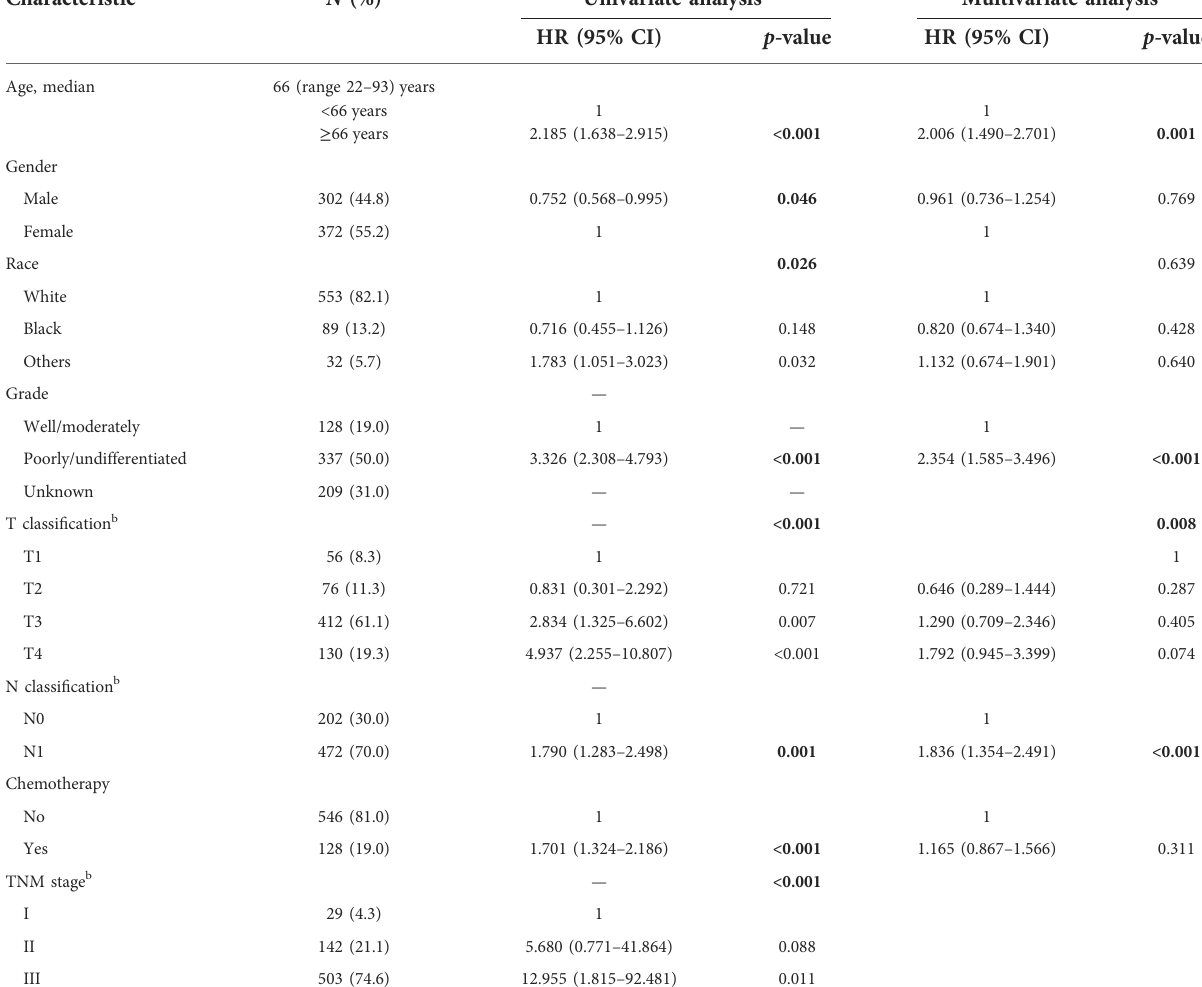
TABLE 1 Univariate and multivariate analysis of CSS in colon NETs in the SEER cohort.